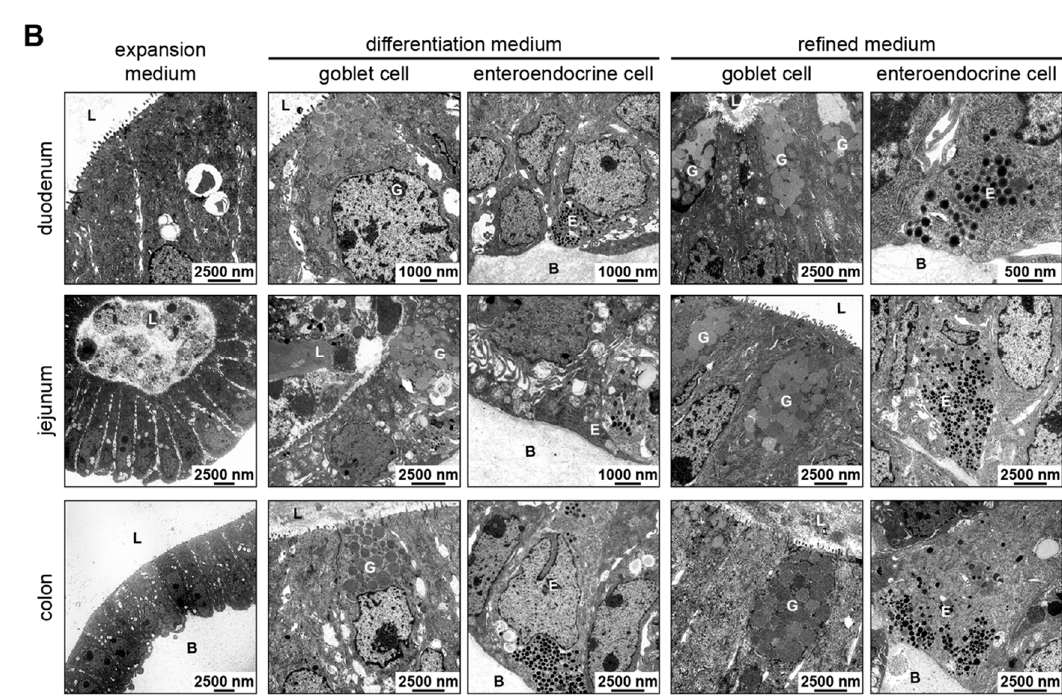
Figure 3. Goblet and enteroendocrine cells are present in organoids upon cultivation in differentiation and refined medium, but not in expansion medium. ( A ) PAS reaction in FFPE sections of canine intestinal tissue or organoids in expansion, differentiation and refined medium derived from duodenum, jejunum and colon; counterstained with Hematoxylin, images of duodenal and jejunal tissue were cropped in order to visualize crypts; scale bars 200 µm, inset depicts higher magnification; arrow heads indicate PAS positive goblet cells; one representative image is shown. ( B ) TEM images of duodenal, jejunal and colonic organoids in expansion, differentiation and refined medium; scale bars are indicated; L, lumen; B, basal lamina; G, goblet cell; E, enteroendocrine cell.